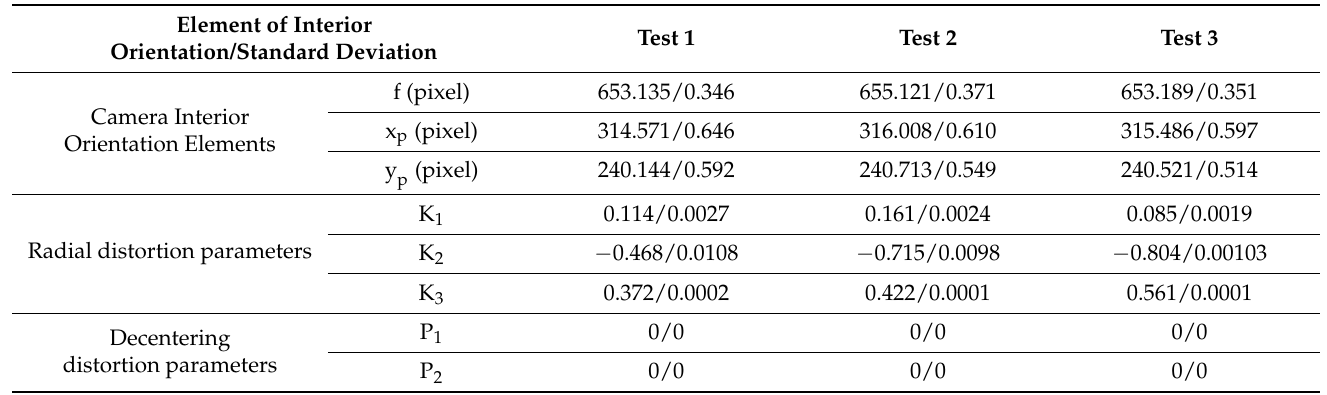
Table 4. Calibration parameters (Mi 10 Lite).